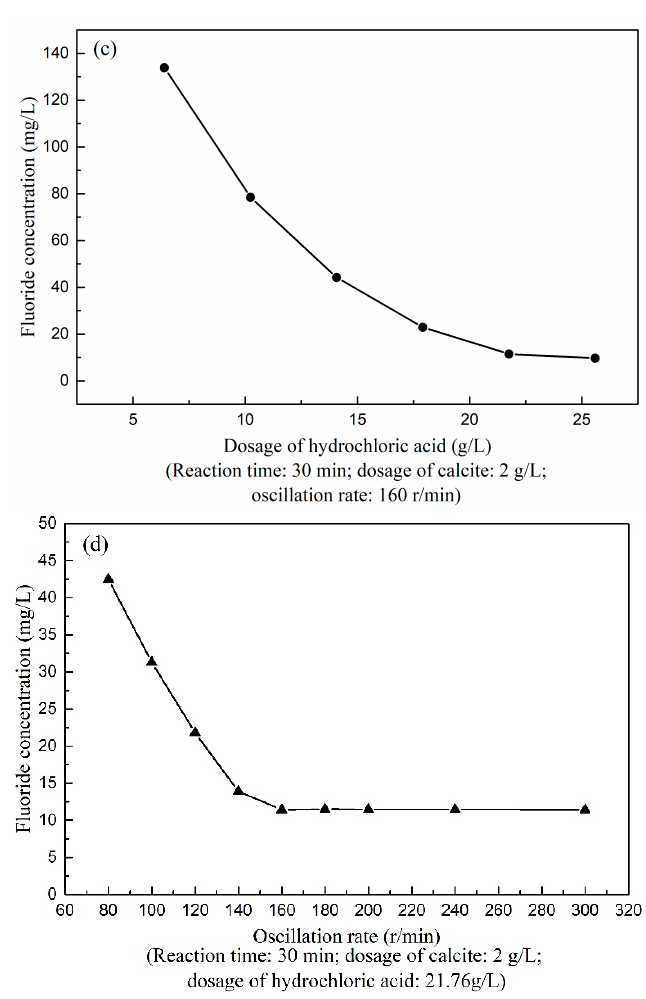
Figure 1. Influence of reaction time ( a ), dosage of calcite ( b ), dosage of hydrochloric acid ( c ), and oscillation rate ( d ) on fluoride removal process from simulated wastewater by calcite.